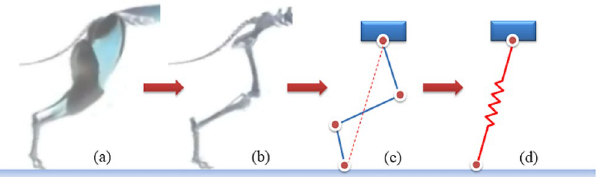
Figure 1. Equivalent process of the single leg. ( a ) Hind leg with muscles. ( b ) Leg bone structure. ( c ) An anchor for the single leg. ( d ) The simplest 2D-SLIP template (the figure is created by Visio 2016, https:// suppo rt. micro soft. com/ visio).